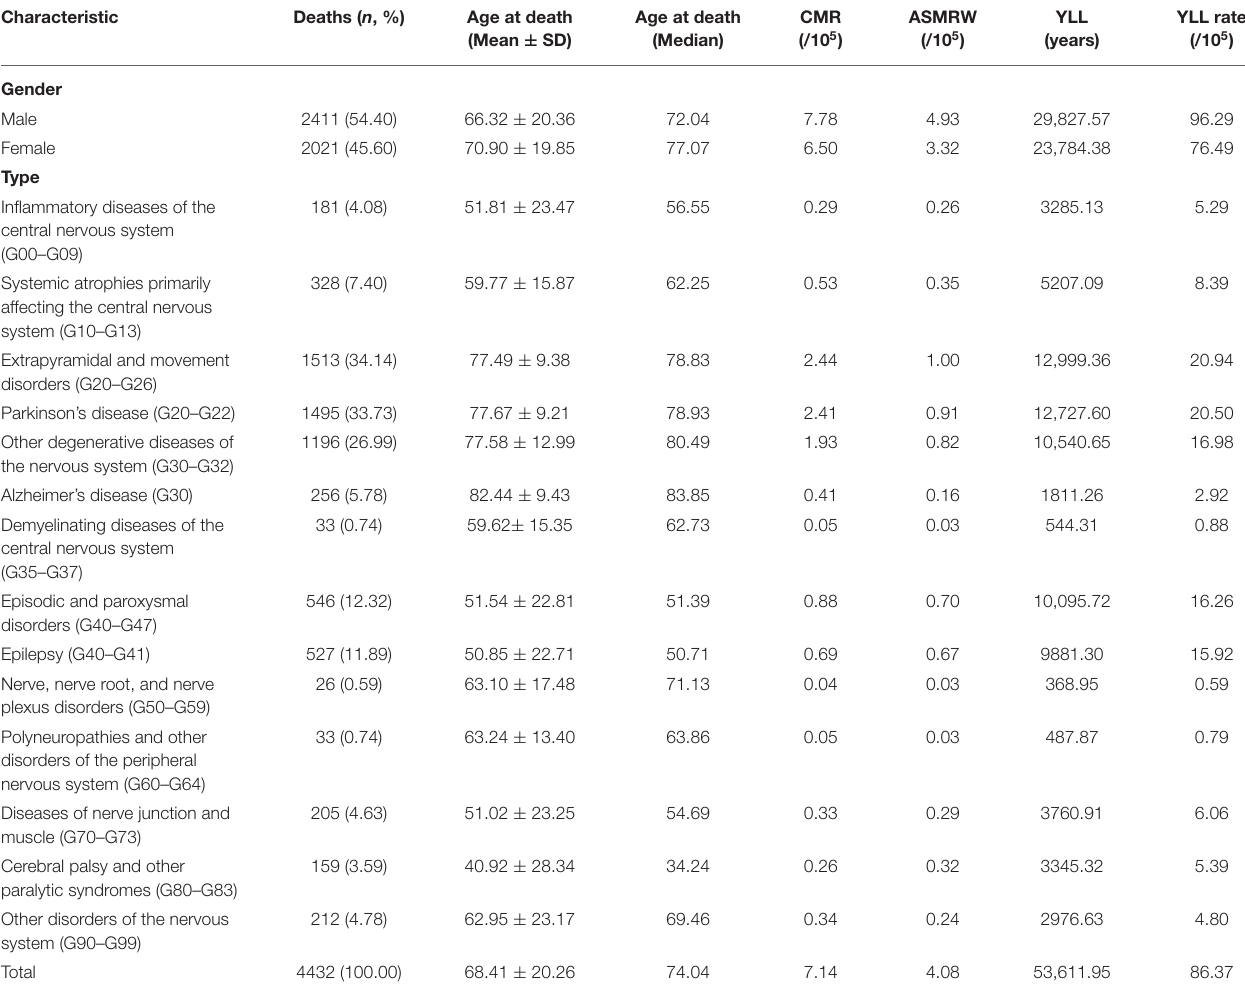
TABLE 1 | Baseline characteristics of deaths and burden in different genders and types of selected neurological disorders during 1995–2018. Characteristic